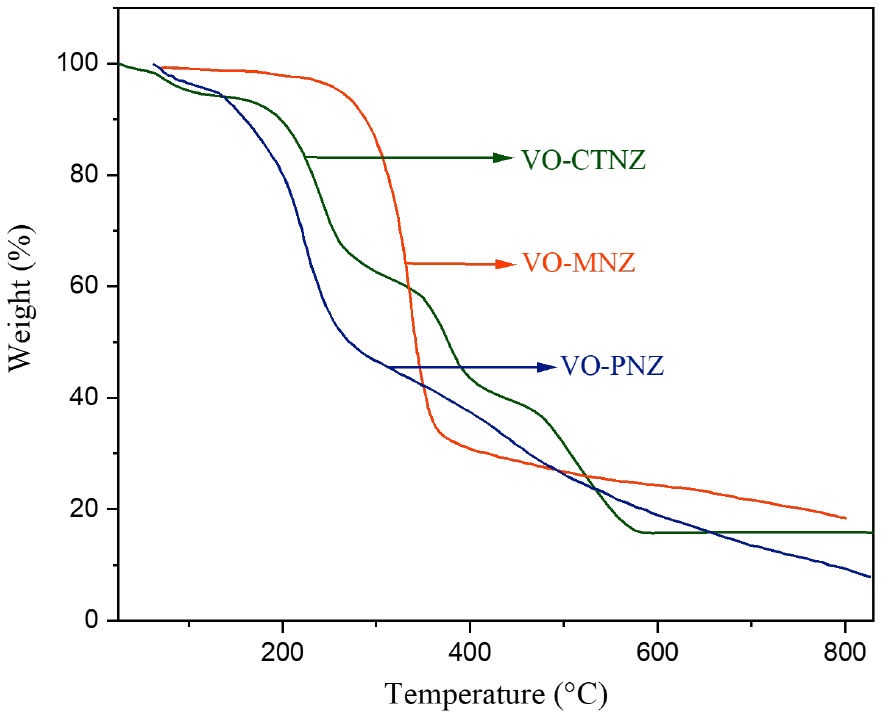
Figure 7. The curves of TG for three oxidovanadium(IV) complexes.